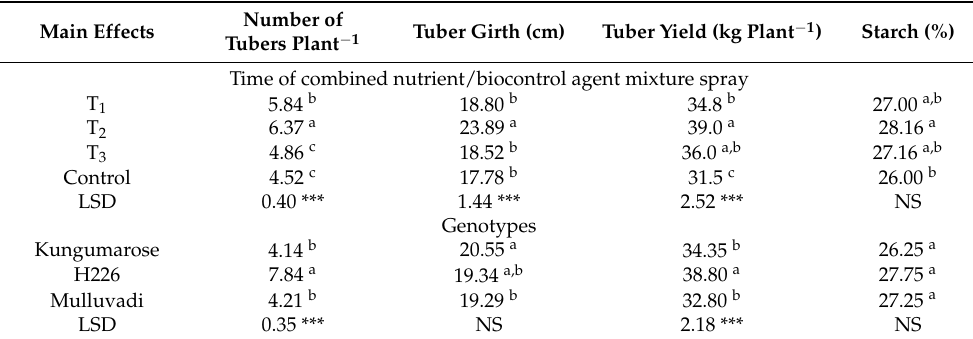
Table 4. Main effect of timing of combined nutrient/biocontrol agent mixture spray and genotypes on the number of tuber plant − 1 , tuber girth (cm), tuber yield (kg plant − 1 ), and starch (%) in cassava ( n = 10). Means followed by the same letter are not statistically significant at p <